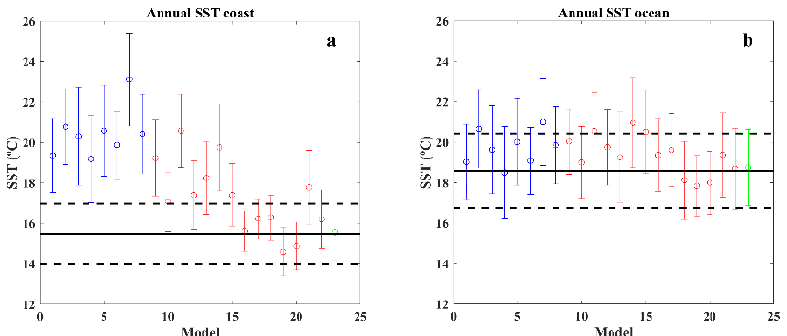
Figure 3. Benguela upwelling system mean SST value (±1 SD) for the OISST ¼ (black solid line) and each CMIP6 model for: ( a ) coastal and ( b ) oceanic points. The number and color of each model refer to Table 1.